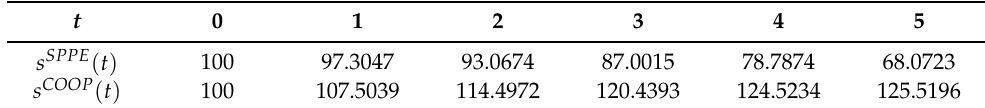
Table 2. SPPE trajectory and cooperative trajectory.